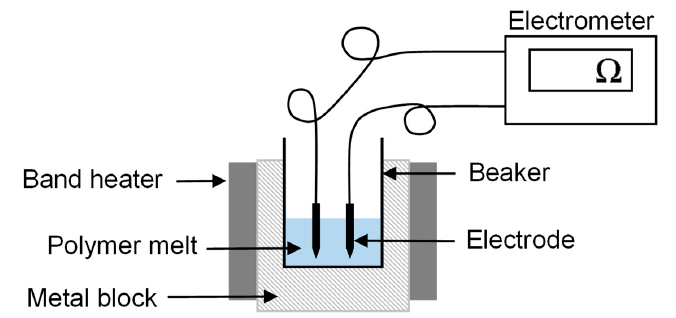
Figure 3. Configuration used for the measurement of electrical resistance.